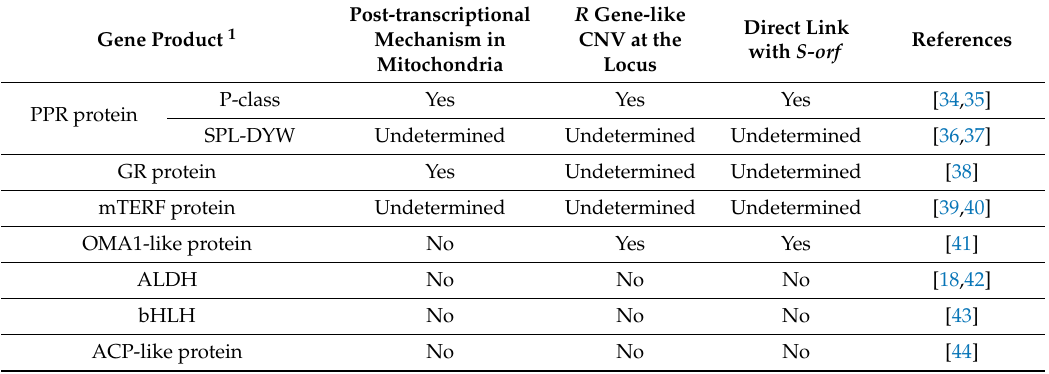
Table 1. Summary of protein products of restorer-of-fertility ( Rf ) and Rf